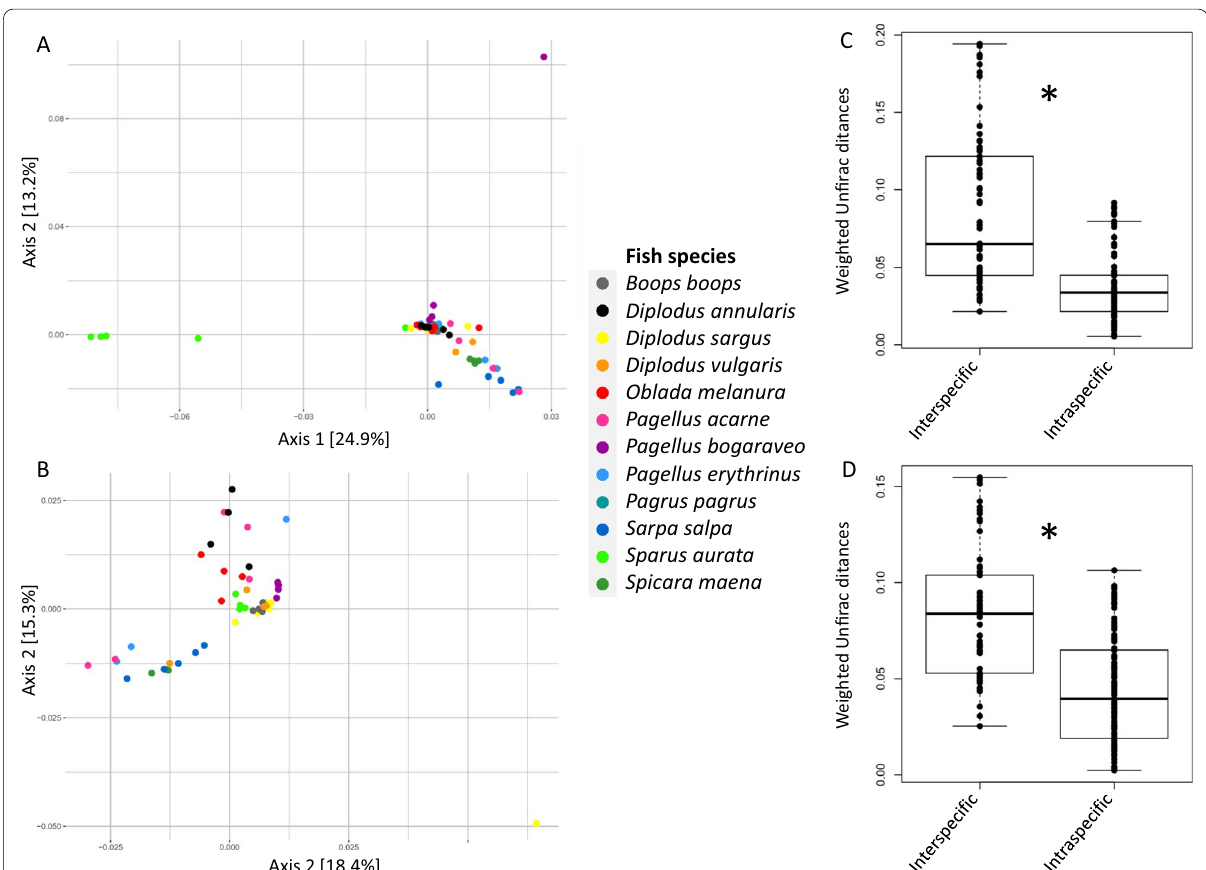
Fig. 5 Dissimilarities between bacterial communities based on weighted Unifrac dissimilarity values. PCoA plot representing all fish gill mucus ( A ) and skin mucus ( B ) microbiota included in this study. Color indicates fish species. Intraspecific and interspecific values based on weighted Unifrac dissimilarity within gill mucus ( C ) and skin mucus ( D ) microbiota. *Significant differences between intraspecific and interspecific values (Kruskal– Wallis test, p < 0.05)